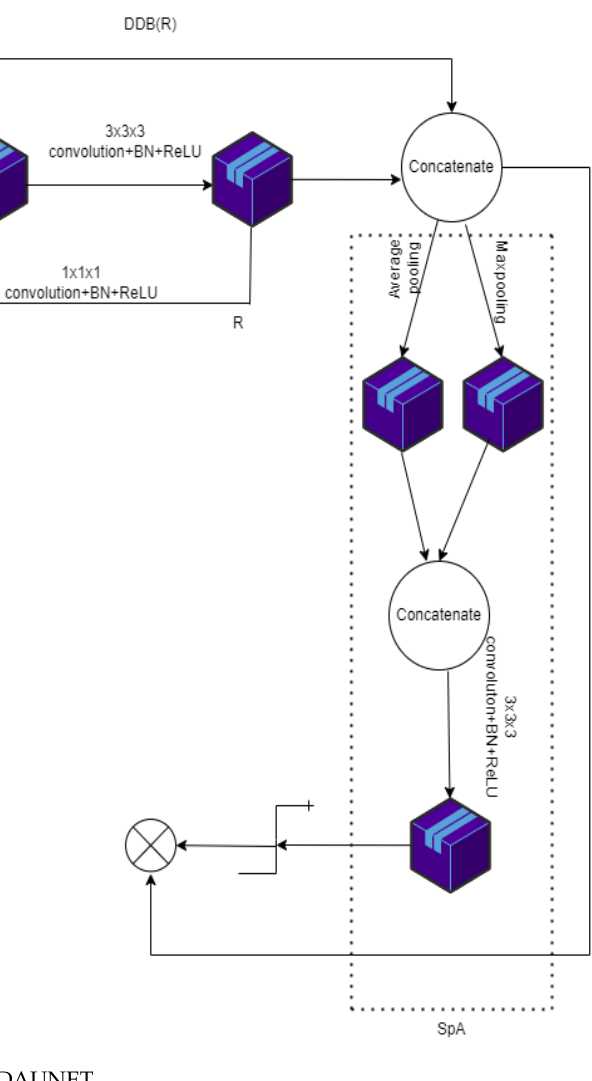
Figure 18. Architecture of